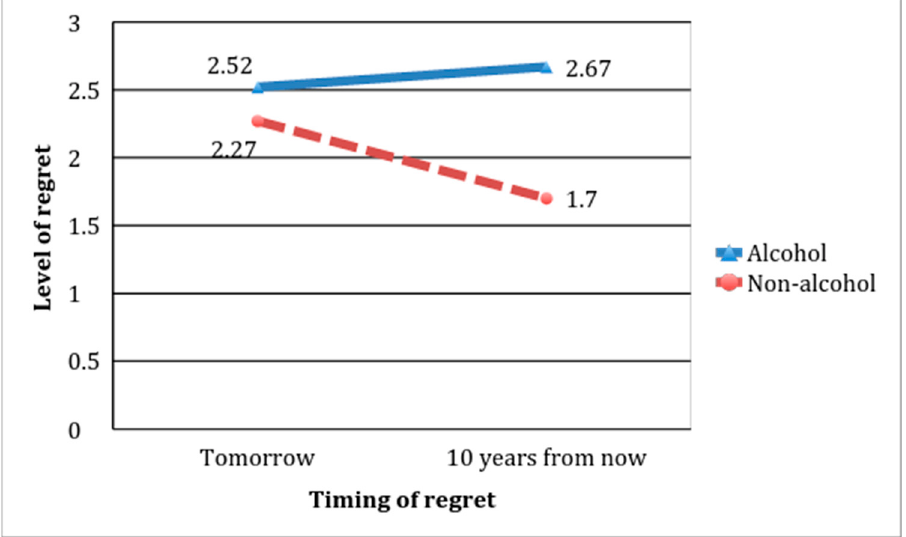
Figure 1. Regret when choosing non-alcoholic beer vs. alcoholic